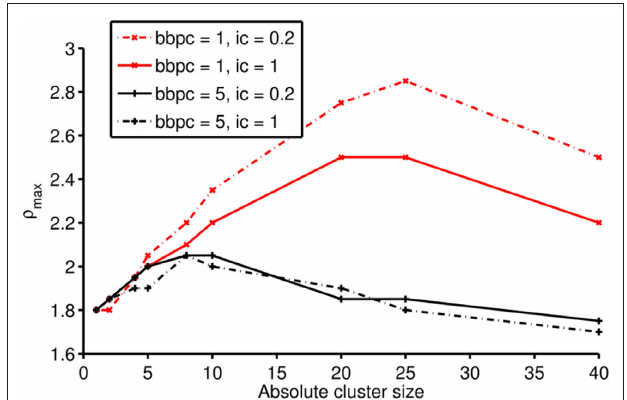
Figure 7 | r for increasing number of clusters for four different max combinations of values for bbpc and conn . The corresponding increases i nter in r are consistent with trends described above. The relative influence of max hierarchy and clustering can be observed by considering the two networks with the same degree count but different distributions: bbpc = 1, conn = 1, inter and bbpc = 5, conn = 0.2. For n > 5 clusters, the former configuration has inter higher values of r , indicating a greater dependence of r on hierarchy max max rather than clustering.